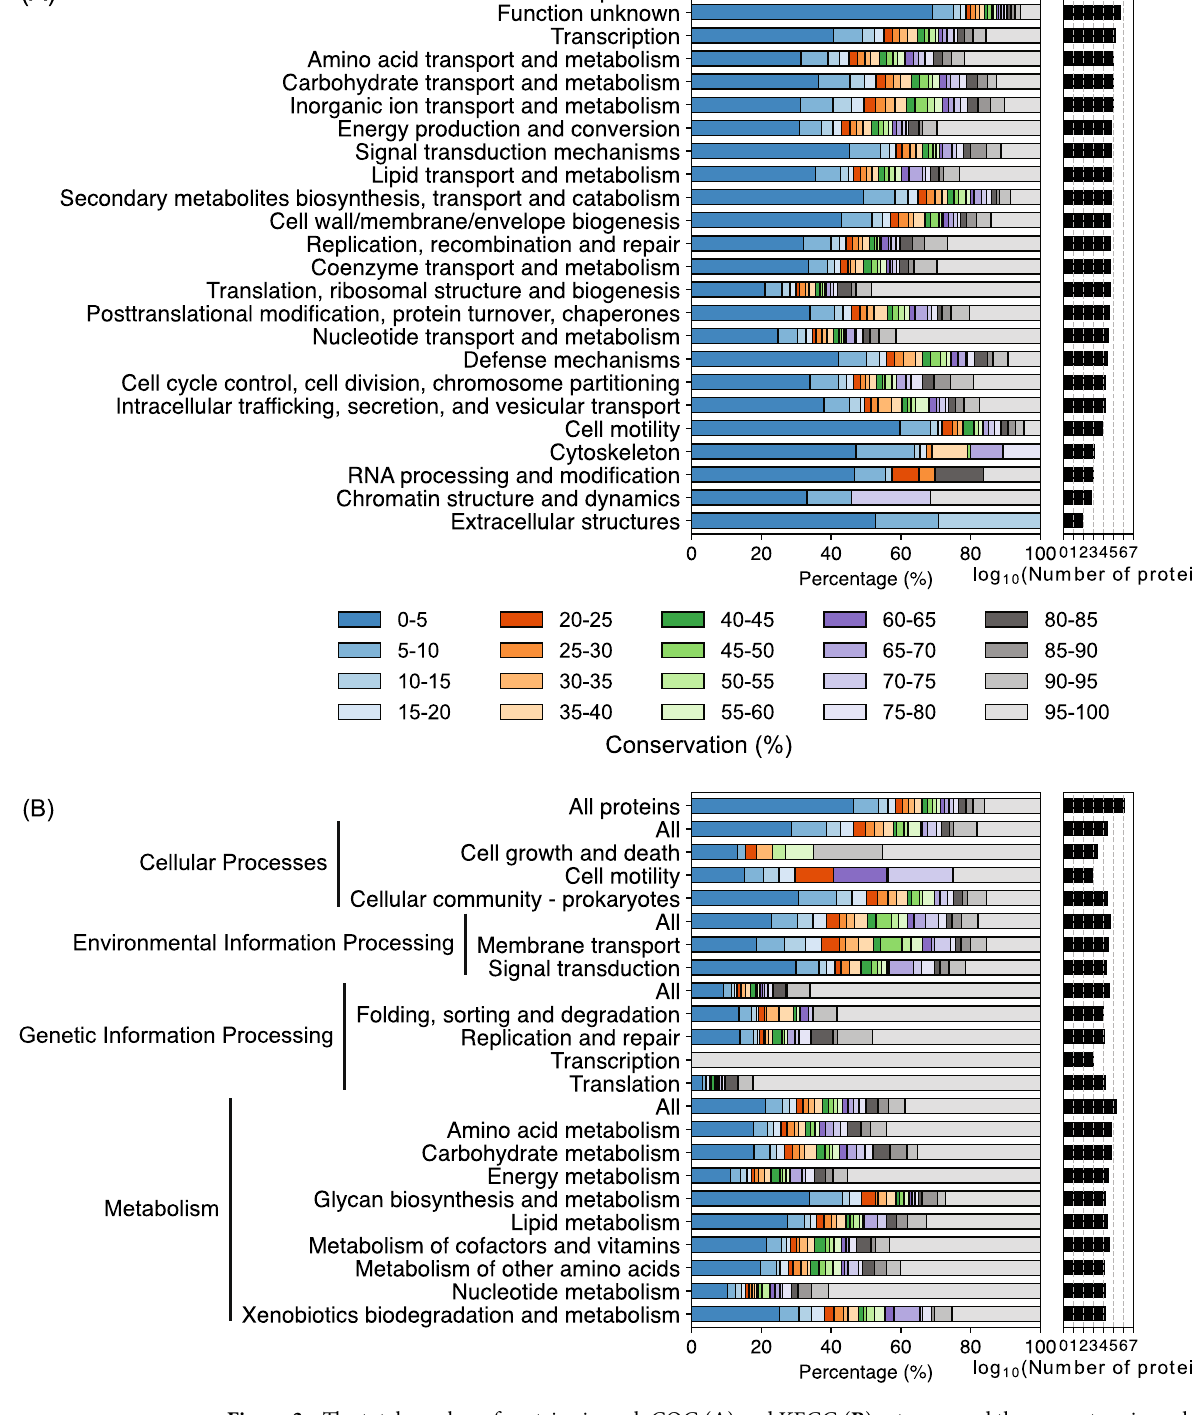
Figure 3. The total number of proteins in each COG ( A ) and KEGG ( B ) category and the percentage in each conservation